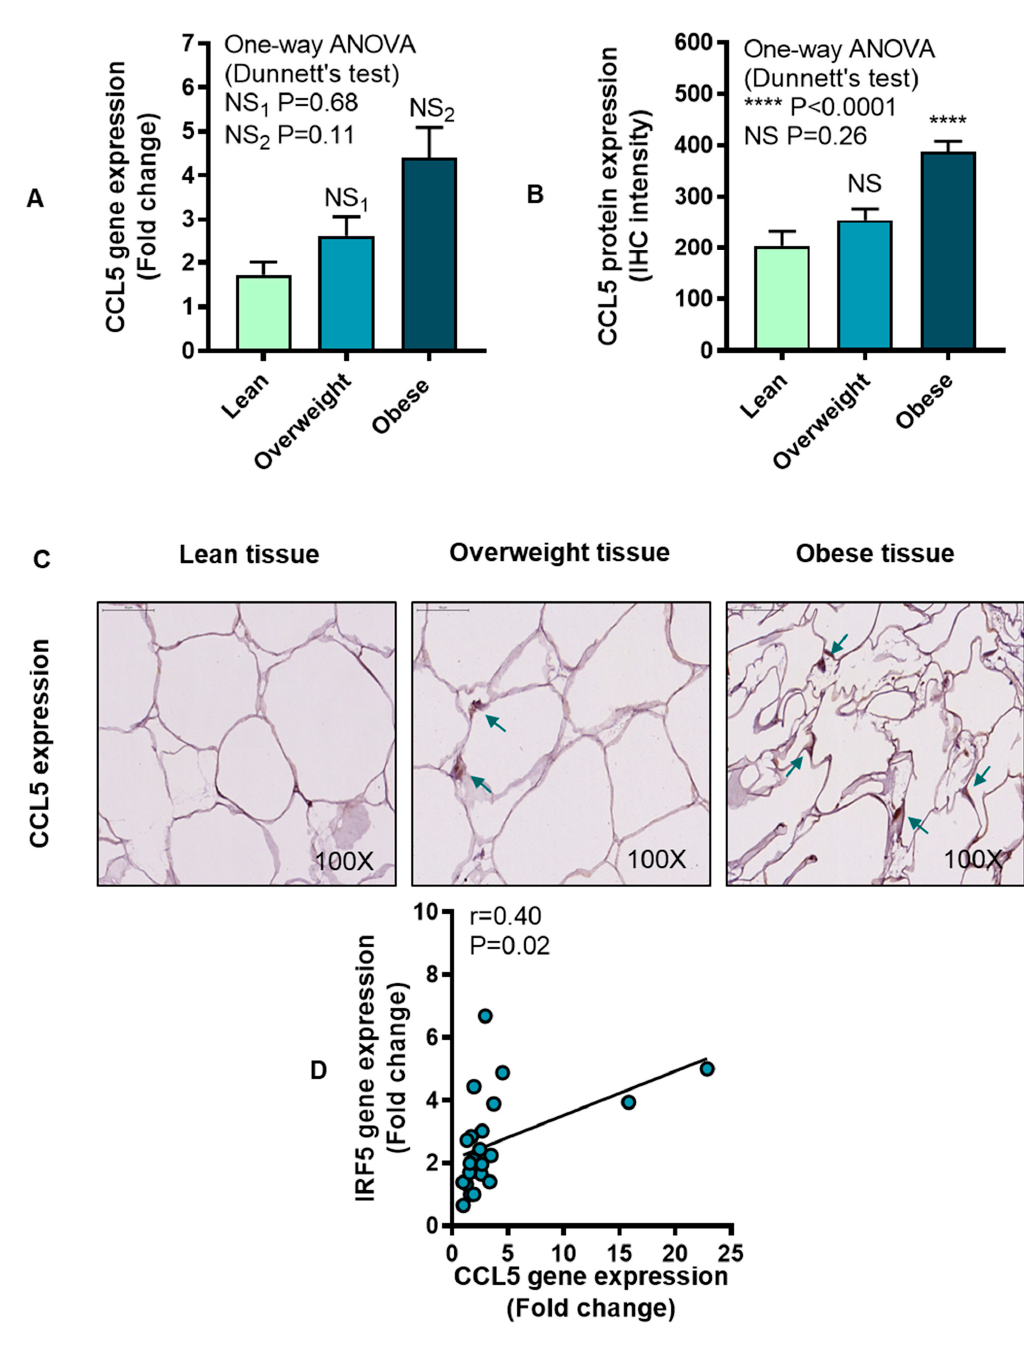
Figure 6. Adipose chemokine CC motif ligand-5 (CCL5) protein expression is elevated in obesity. CCL5 transcripts / messenger RNA (mRNA) expression was assessed in four lean, 18 overweight, and 23 obese non-diabetic subjects using real-time RT-PCR, while CCL5 protein expression was determined in six lean, 14 overweight, and 10 obese non-diabetic subjects using immunohistochemistry (IHC) as described in Materials and Methods. The data (mean ± SEM) show that ( A ) increase in CCL5 transcripts in overweight and obese compared with lean individuals was non-significant (P > 0.05). ( B ) CCL5 protein expression (IHC intensity shown in arbitrary units) was increased in obese (P < 0.0001) as compared with lean subjects. ( C ) The representative IHC images obtained from three independent determinations with similar results show increased CCL5 adipose expression (turquoise arrows, 100 × magnification) in overweight and obese as compared with lean individuals. Scale bar = 50 µ M. ( D ) IRF5 and CCL5 gene expression correlated in the adipose tissue (r = 0.40, P = 0.02). The **** asterisks represent significance level of P ˂ 0.0001. CCL2, also known as monocyte chemoattractant protein (MCP)-1, is involved in recruiting monocytes, dendritic cells, and memory T cells to the sites of inflammation. We asked if CCL2 expression was elevated and correlated with IRF5 expression in the adipose tissue. The data show that adipose CCL2 gene (P = 0.05, Figure 7A) and protein (P < 0.0001, Figure 7B) expression was enhanced in obese individuals compared with lean. The representative IHC images from three independent determinations with similar results show CCL2 protein expression (arrows) in the adipose tissue samples from lean, overweight, and obese individuals (Figure 7C). CCL2 gene and protein expression in the adipose tissue did not associate with each other (r = 0.10, P = 0.70, Supplementary Figure S1E). Moreover, no correlation was found between IRF5 and CCL2 gene expression in the adipose tissue (r = 0.12, P = 0.42) (Figure 7D).